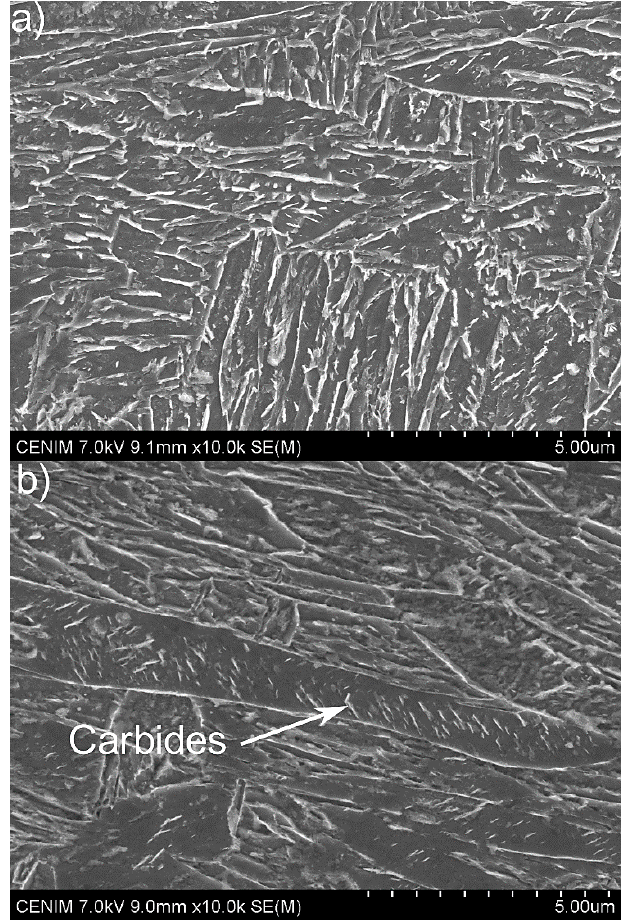
Figure 7. The SEM microstructures of the steel after tempering for ( a ) 15 and ( b ) 60 min.